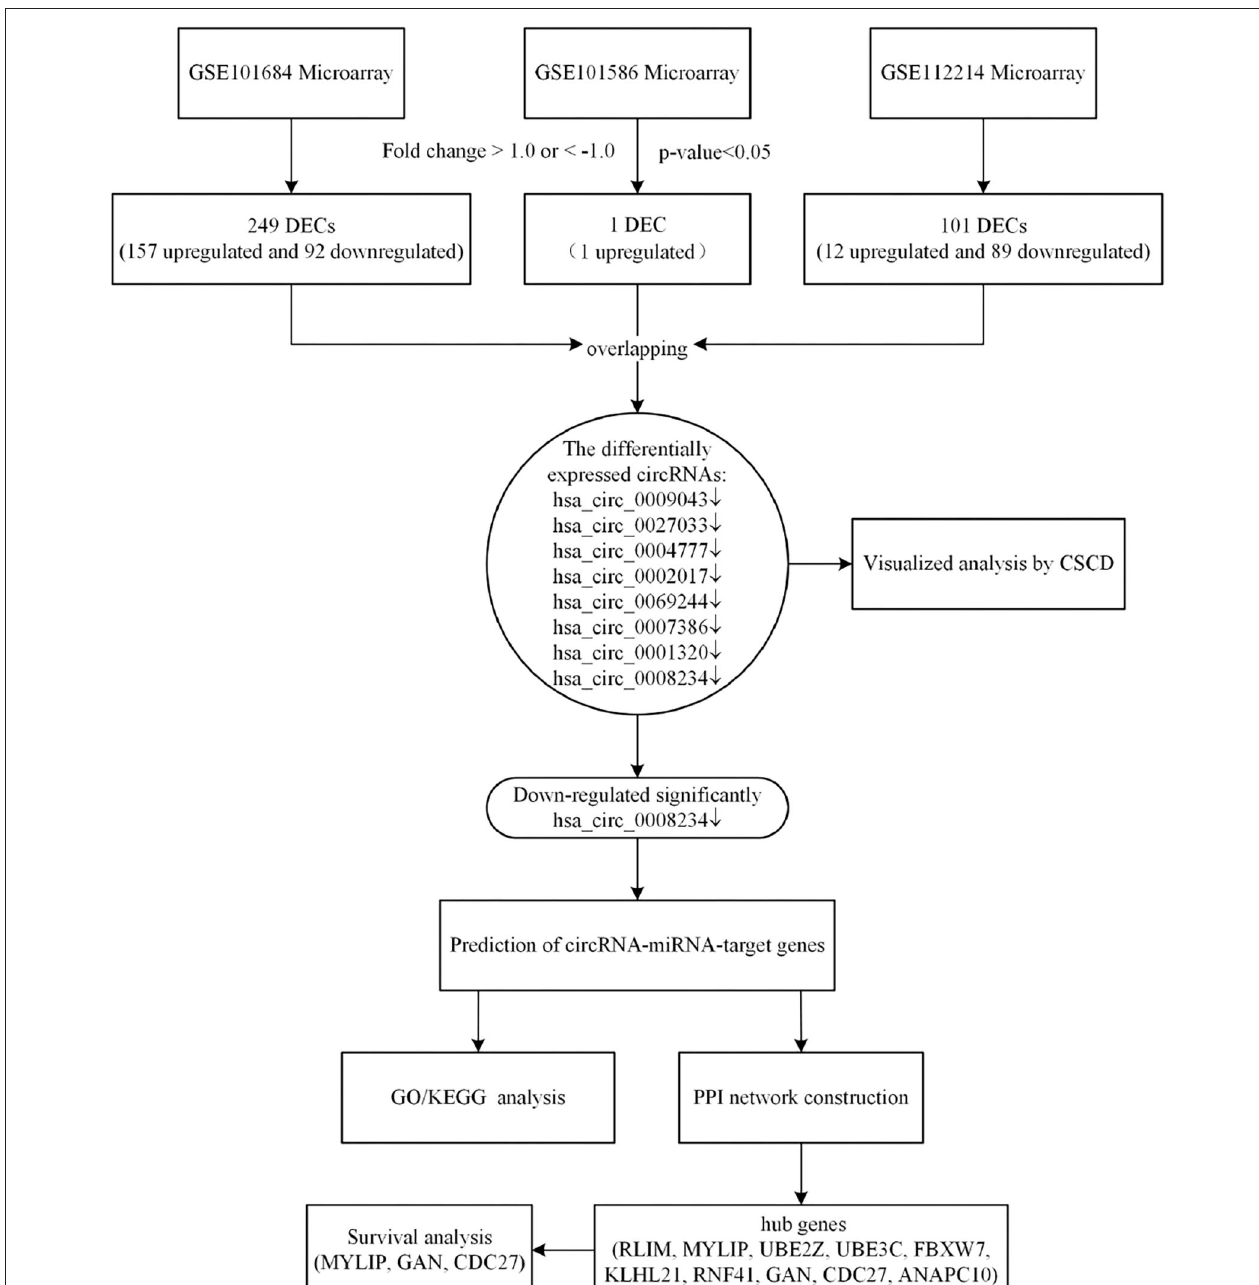
FIGURE 1 | The bioinformatics workflow of this study.